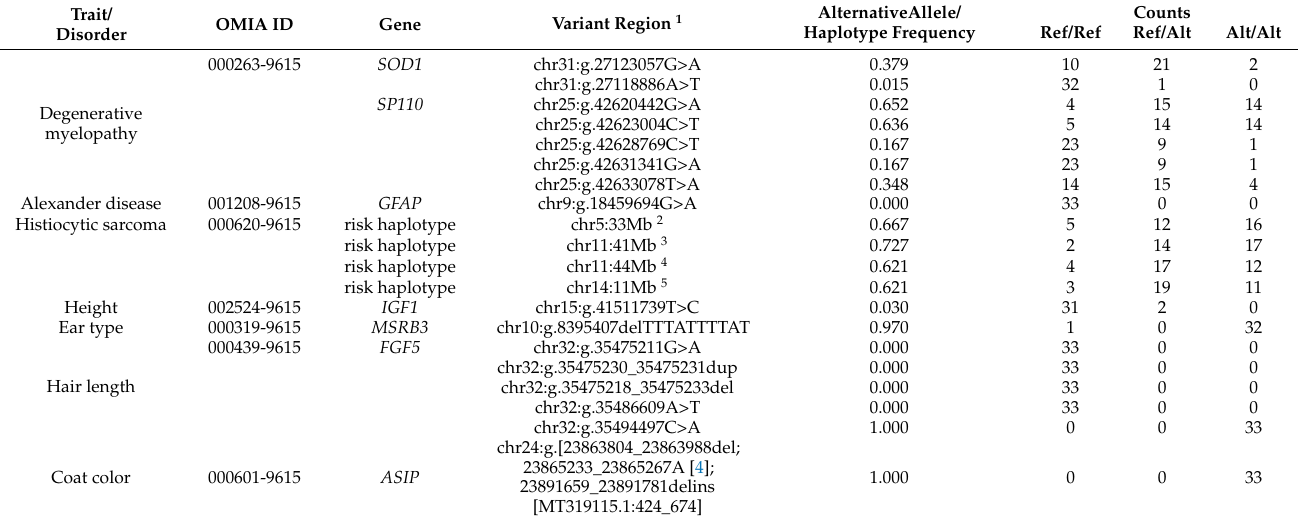
Table 2. List of selected breed-relevant variants and their distribution in 33 Bernese mountain